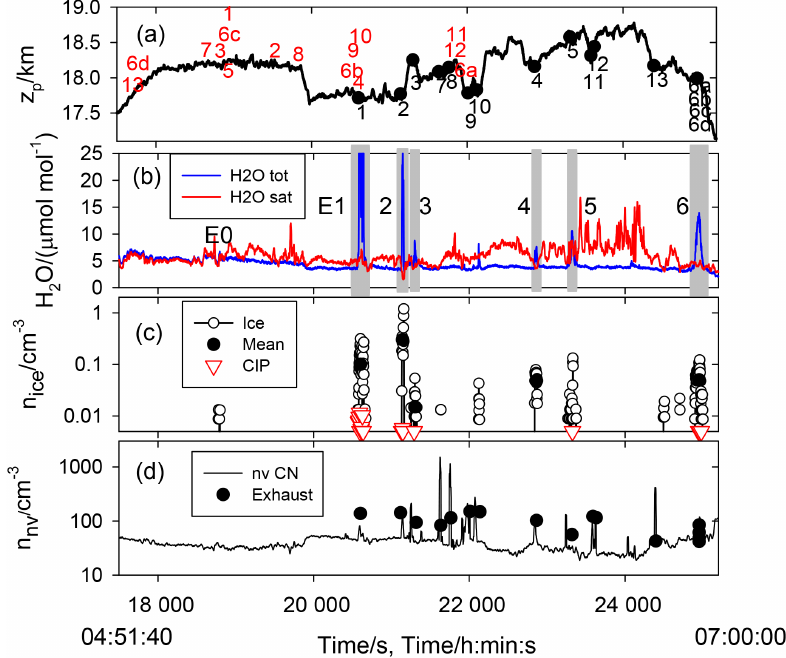
Figure 6. In situ data measured during Geophysica flight in the morning of the Hector day, 30 November 2005 versus UTC time. (a) Pressure altitude with numbered positions (C, red symbols) where contrails formed that might have caused aerosol and corresponding events E (black symbols) later. There are 16 events, here numbered 1 to 13, with event E6 having four source contrails 6a to 6d of different ages. (b) Molar water vapor mixing ratio H 2 O inµmolmol − 1 (blue: total from FISH; data before time 19800 s are shown though classified as possibly being contaminated by initial outgassing in the measurements); red: H 2 O ice saturation; gray bars: events E1 to E6 with time periods of high ice particle concentrations (de Reus et al., 2009). (c) Black line with white circles: ice number concentration n ice from FSSP100; black symbols: mean n ice values for events E1 to E6 from de Reus; red triangles: indicate that concentrations >0.005cm − 3 or at least one CIP particle >30µm has been measured. (d) Number concentration n nv of non-volatile particles (size >10nm) from COPAS; black symbols: computed n nv for given plume age, fuel consumption, and PEI nv